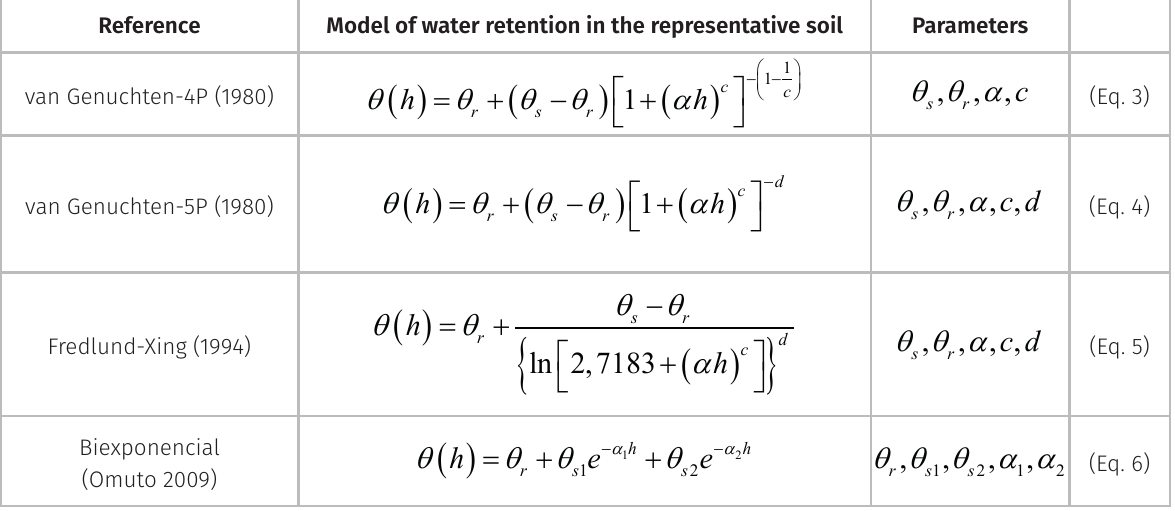
Table III. Models of water retention in soil used for different management in a medium-textured kaolinitic soil. Reference Model of water retention in the representative soil